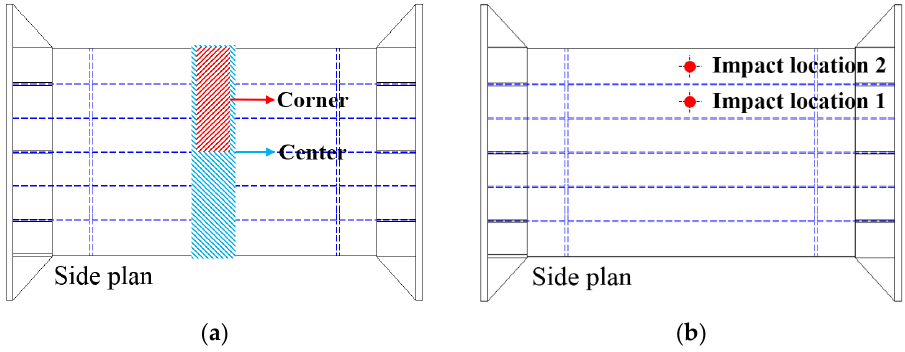
Figure 6. Impact locations of the collision test: ( a ) denting damage; ( b ) fracture damage.